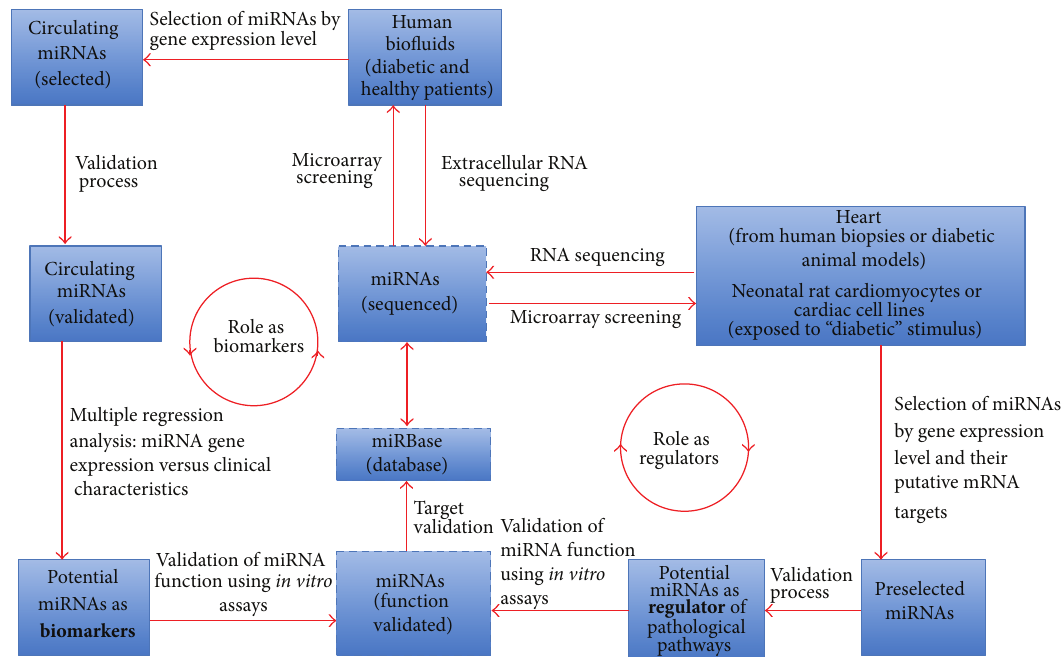
Figure 1: Experimental strategies for circulating microRNA identification as potential